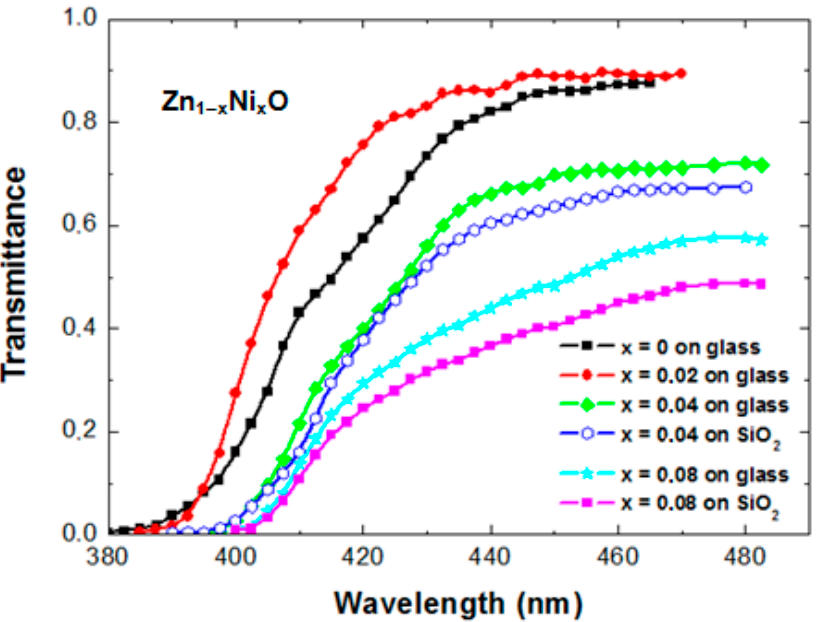
Ni x O thin films on different substrates near the absorption − x